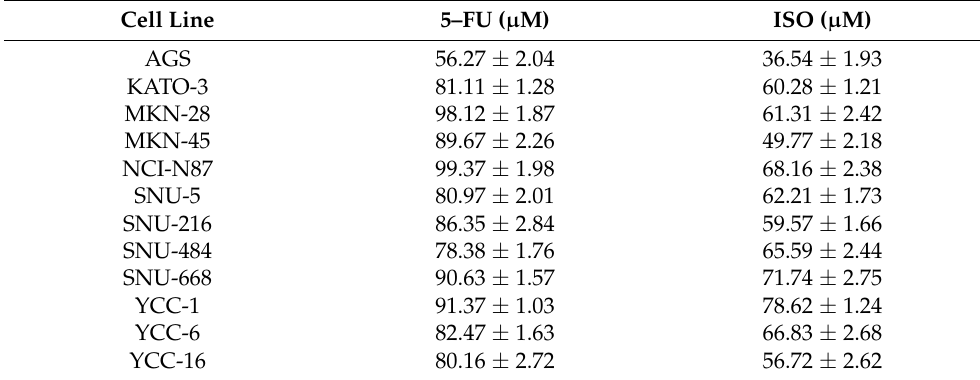
Table 1. IC 50 values of ISO and 5–FU in gastric cancer cells.